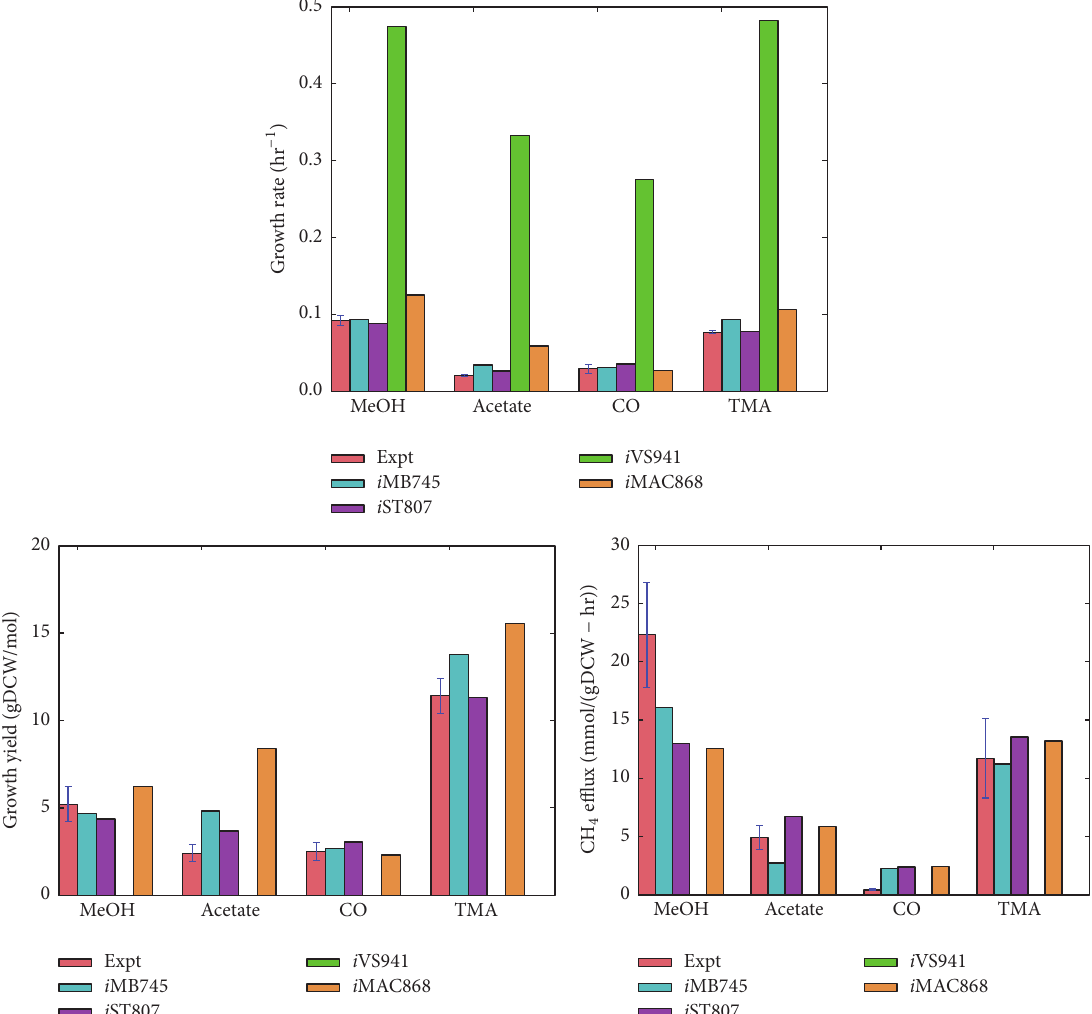
Figure 4: Growth characteristics of M. acetivorans models. The models were simulated using experimental growth substrate uptakes of MeOH:20, Acetate:7, and CO:11.6mmol/gDCW/hr. Since experimental TMA uptake rates were not available, it was set to 6.77 mmol/gDCW/hr across all the models. This value was determined by fitting i ST807 to experimental growth rates on TMA. i VS941 gave unrealistically large growth yields and therefore the values were omitted from the growth yield plot for a clearer display of the other models’ performances. i VS941 also did not predict any methane production under the given growth conditions. Experimental growth rates are from [30–40]. Experimental growth yields are from [40–42]. Experimental CH 4 production rates are from [33,